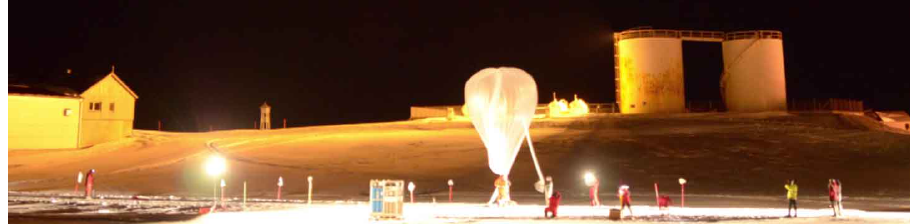
Figure 1. Launch of a stratospheric balloon from Svalbard during the Arctic